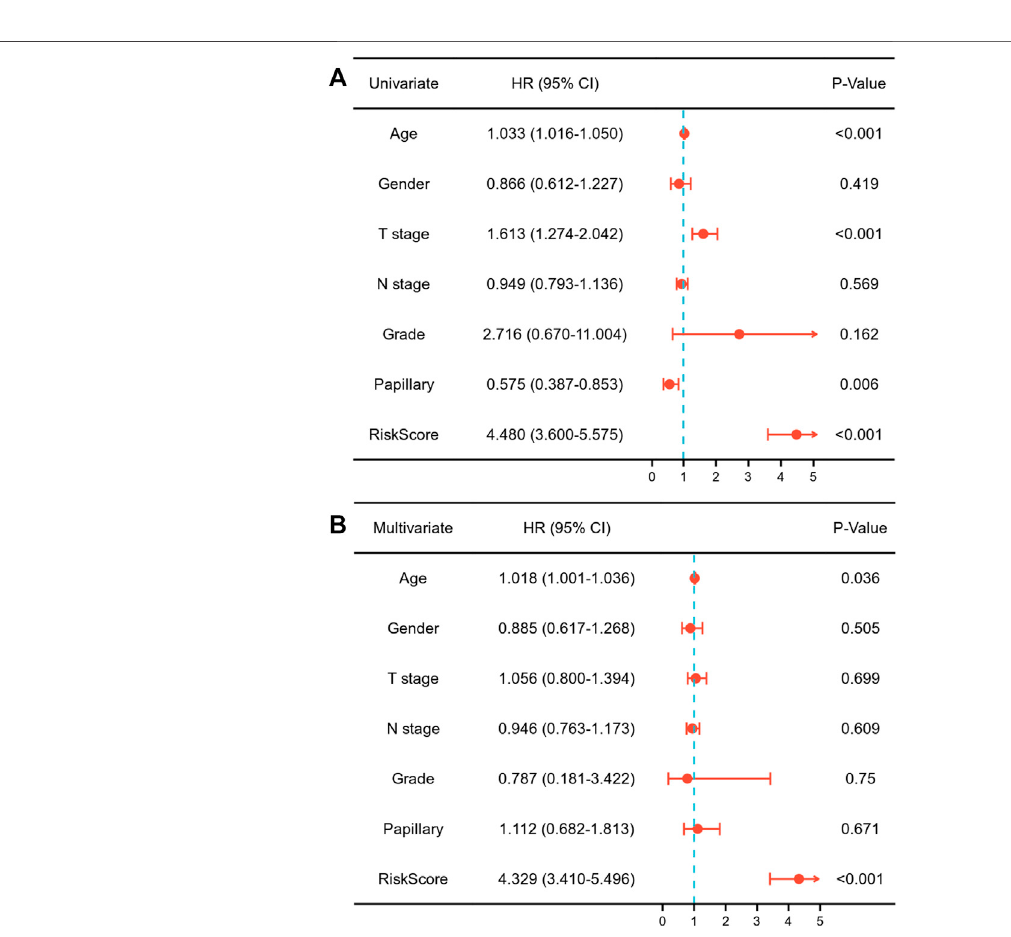
Frontiers in Genetics |